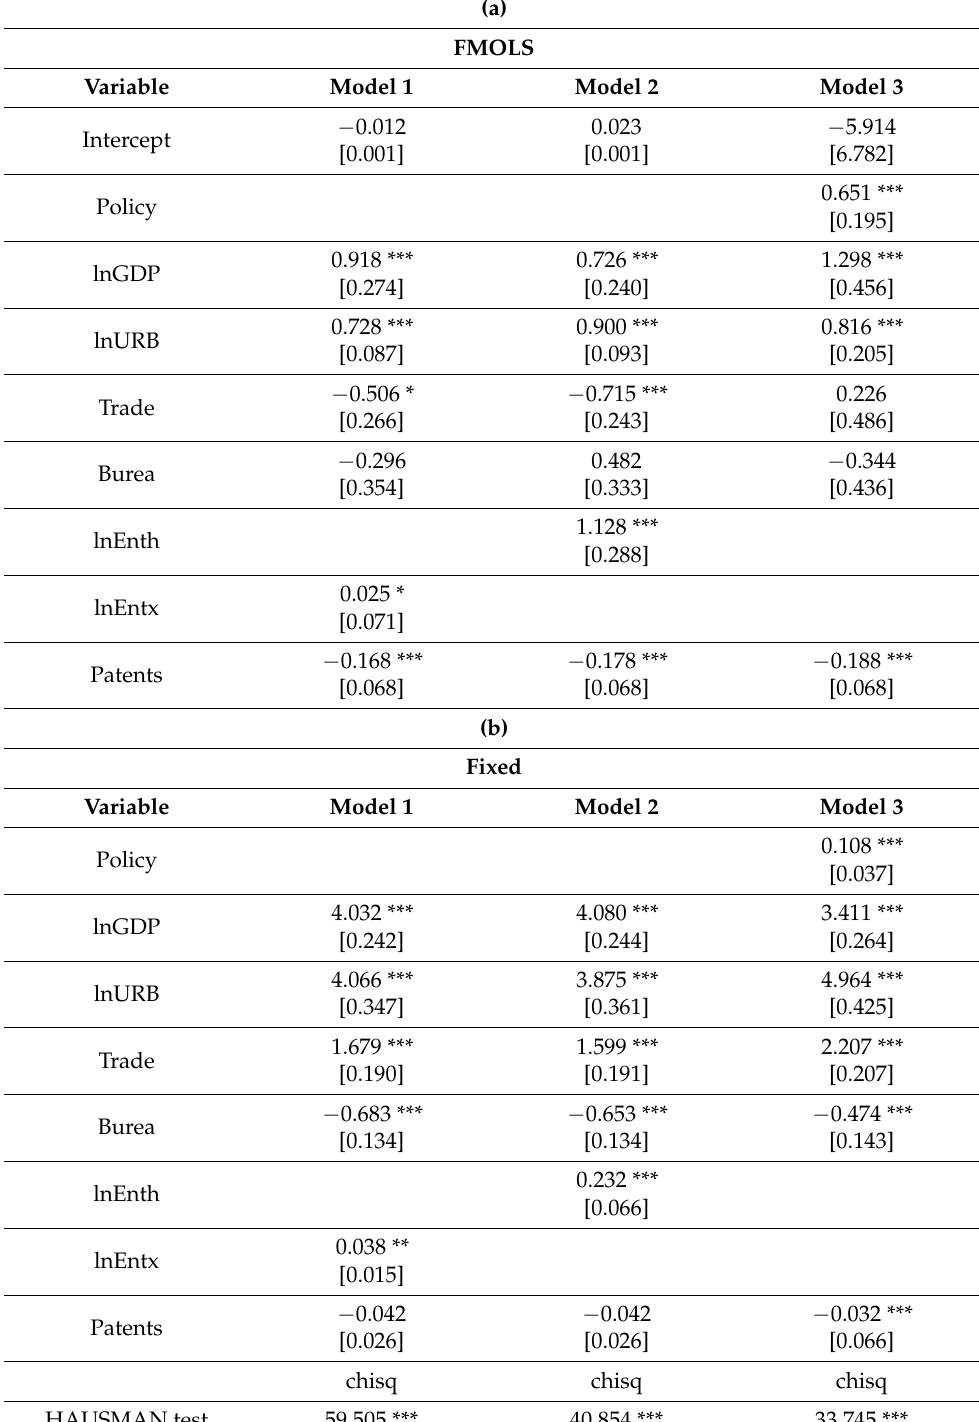
Table 6. (a) Long run estimates using folly modified ordinary least square (FMOLS). (b) Long run estimates using fixed